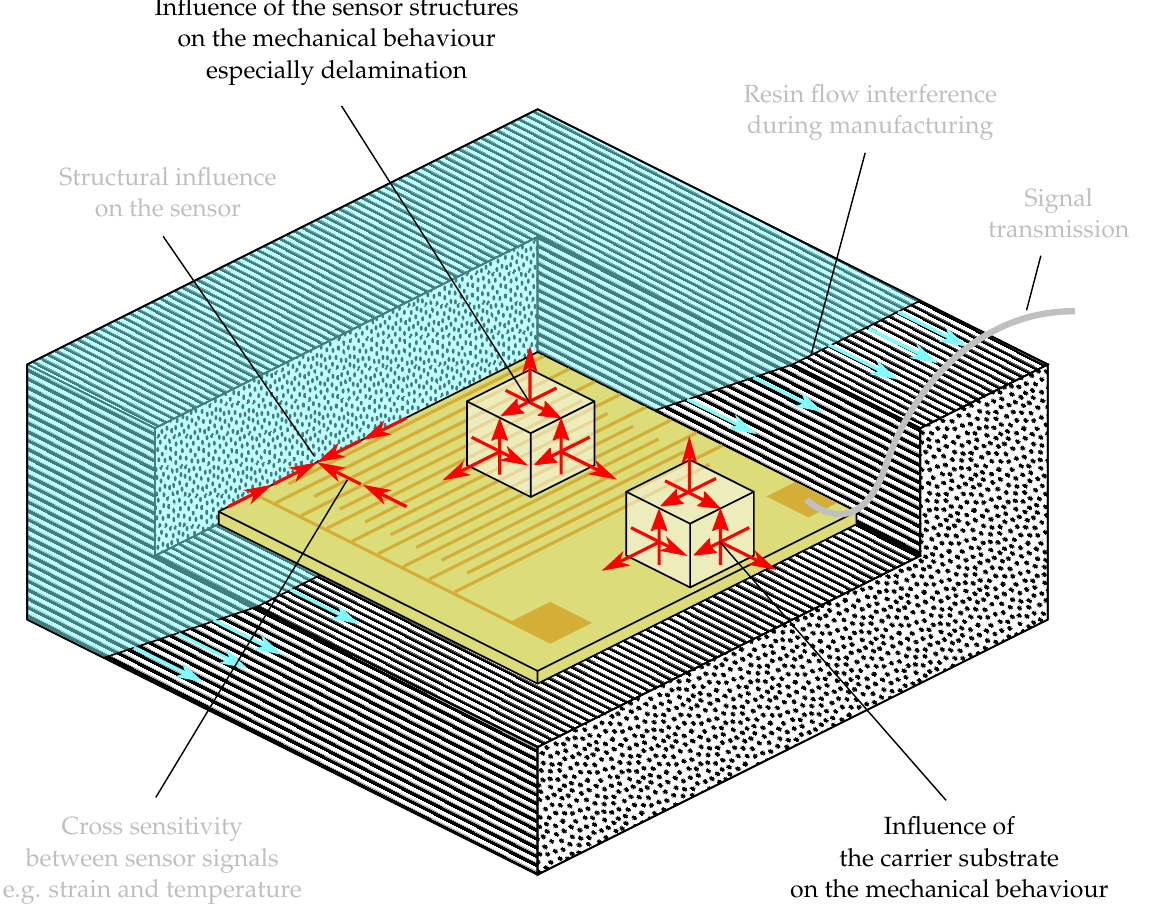
Figure 1. Questions arising from sensor integration into fibre-reinforced